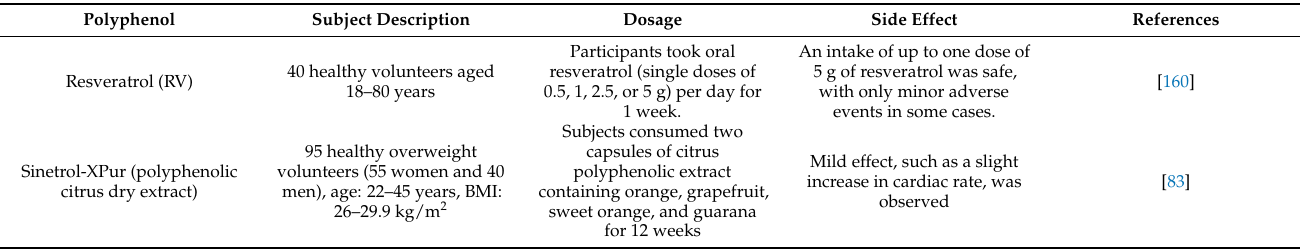
Table 7. Studies investigating the safety of polyphenols in human clinical